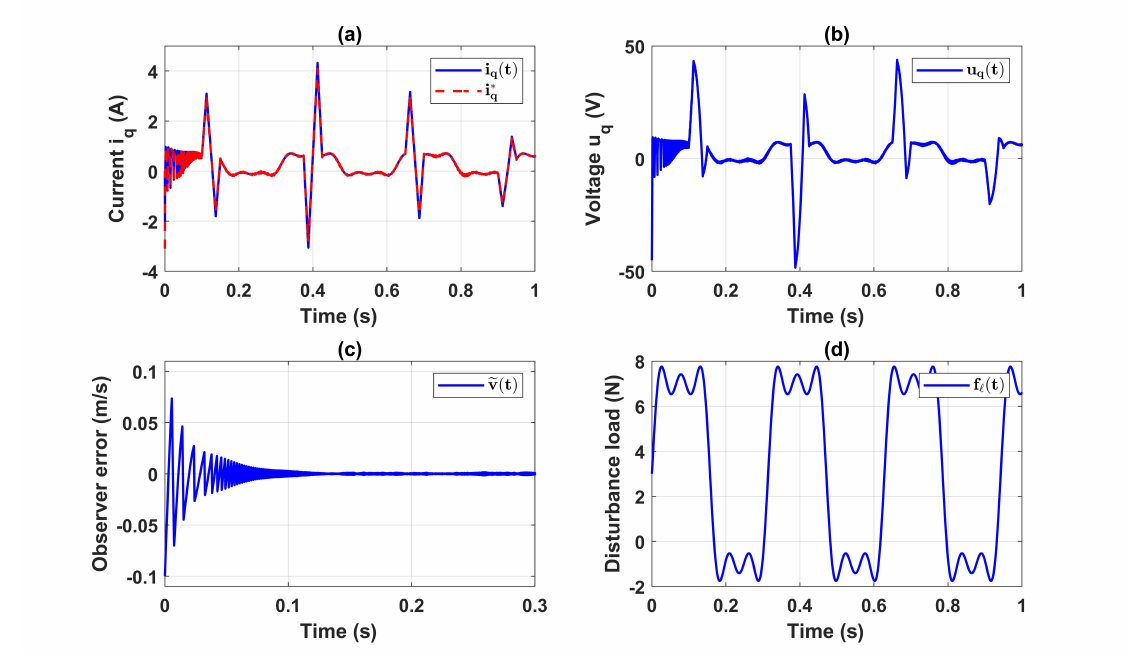
Figure 5. Time behavior of ( a ) quadrature current; ( b ) quadrature voltage; ( c ) velocity observer error; ( d ) disturbance